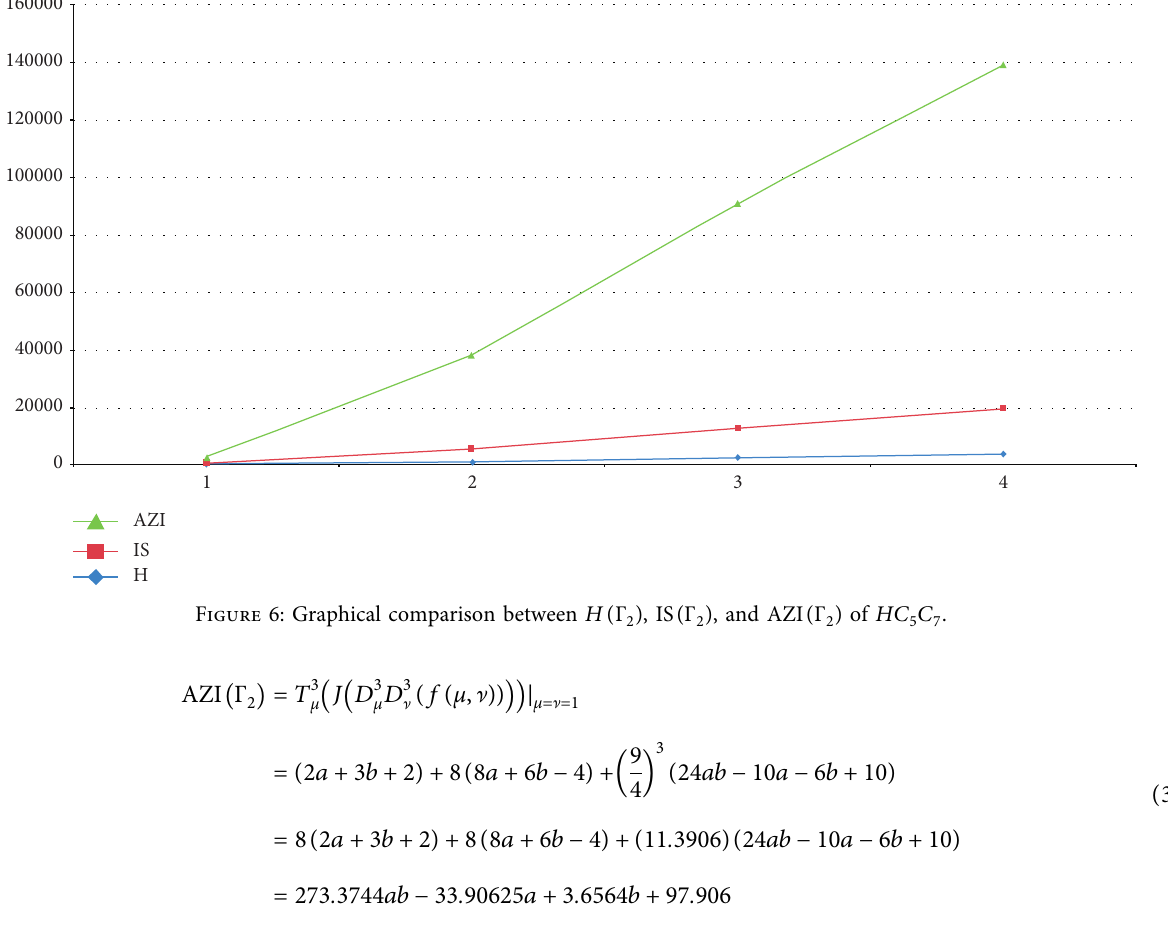
) , IS ( Γ ) , and AZI ( Γ 2 2